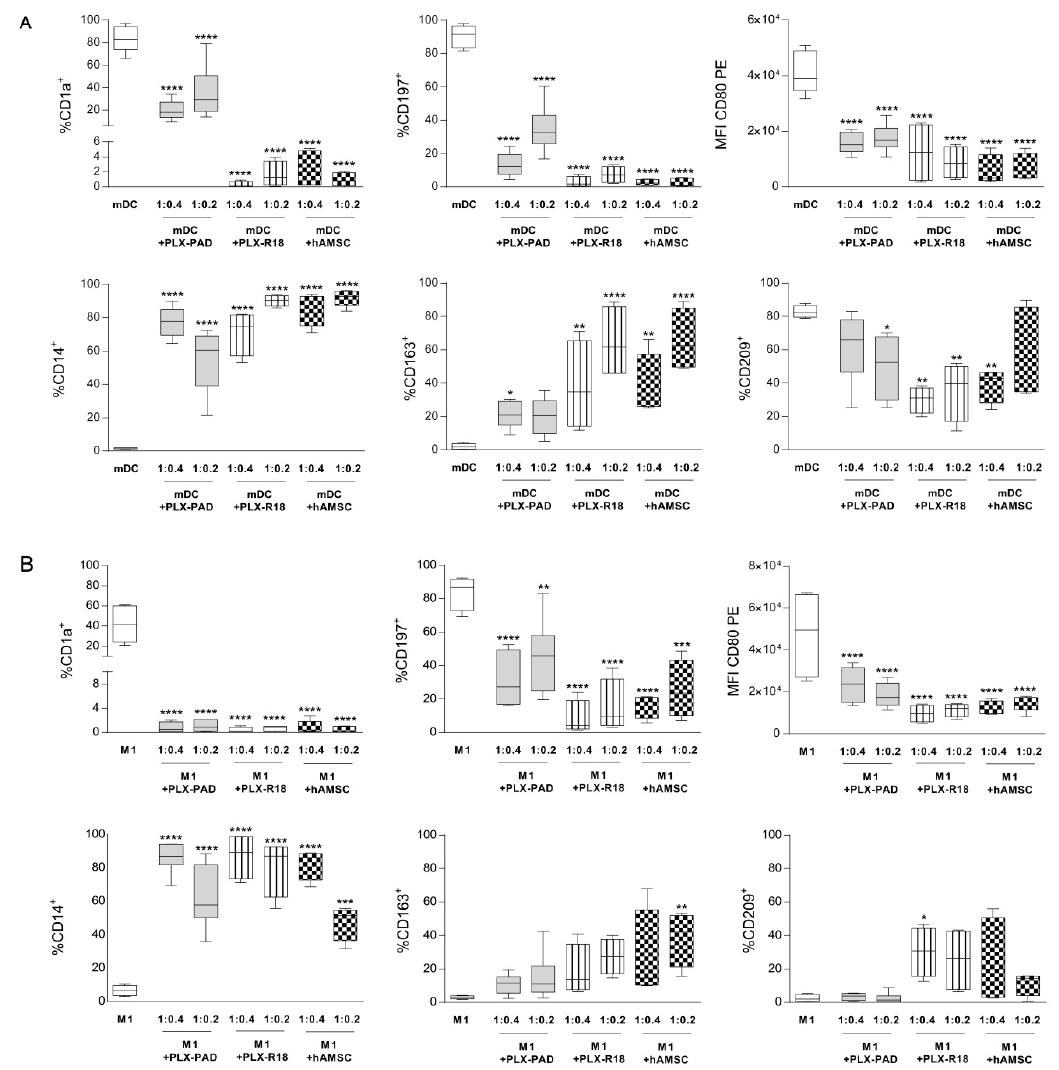
Figure 5. E ff ect of placental cells on the monocyte to APC di ff erentiation. Phenotypic analysis of Figure 5. Effect of placental cells on the monocyte to APC differentiation . Phenotypic analysis of isolated CD14 + monocytes di ff erentiated into ( A ) mature dendritic cells (mDC) or ( B ) M1 macrophages isolated CD14 + monocytes differentiated into ( A ) mature dendritic cells (mDC) or ( B ) M1 in the absence or presence of maternal (PLX-PAD)-derived or fetal (PLX-R18 or hAMSC)-derived cells. macrophages in the absence or presence of maternal (PLX-PAD)-derived or fetal (PLX-R18 or mDC di ff erentiation was carried out by incubating the cells with GM-CSF + IL-4 for four days hAMSC)-derived cells. mDC differentiation was carried out by incubating the cells with GM-CSF+IL-